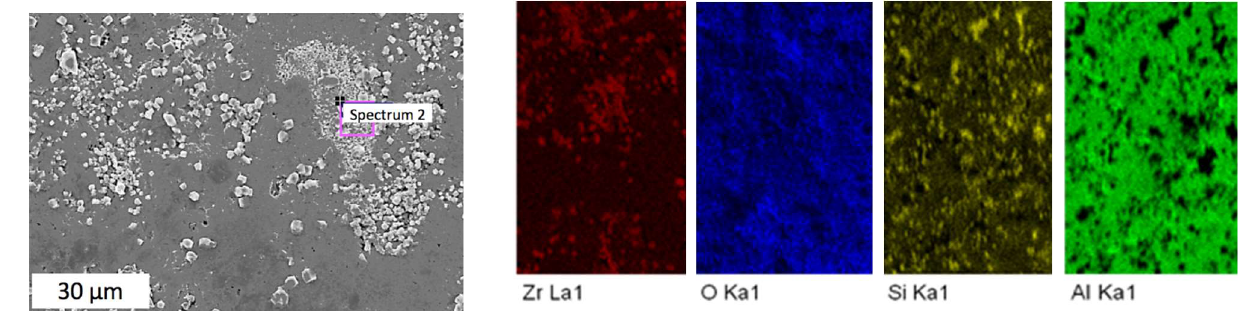
Materials 2022 , 15 , x FOR PEER REVIEW Figure 8. Elemental analysis in point 2 of the sample #4. Figure 8. Elemental analysis in point 2 of the sample #4. Table 2. Elemental proportions in point 2 of the sample #4.